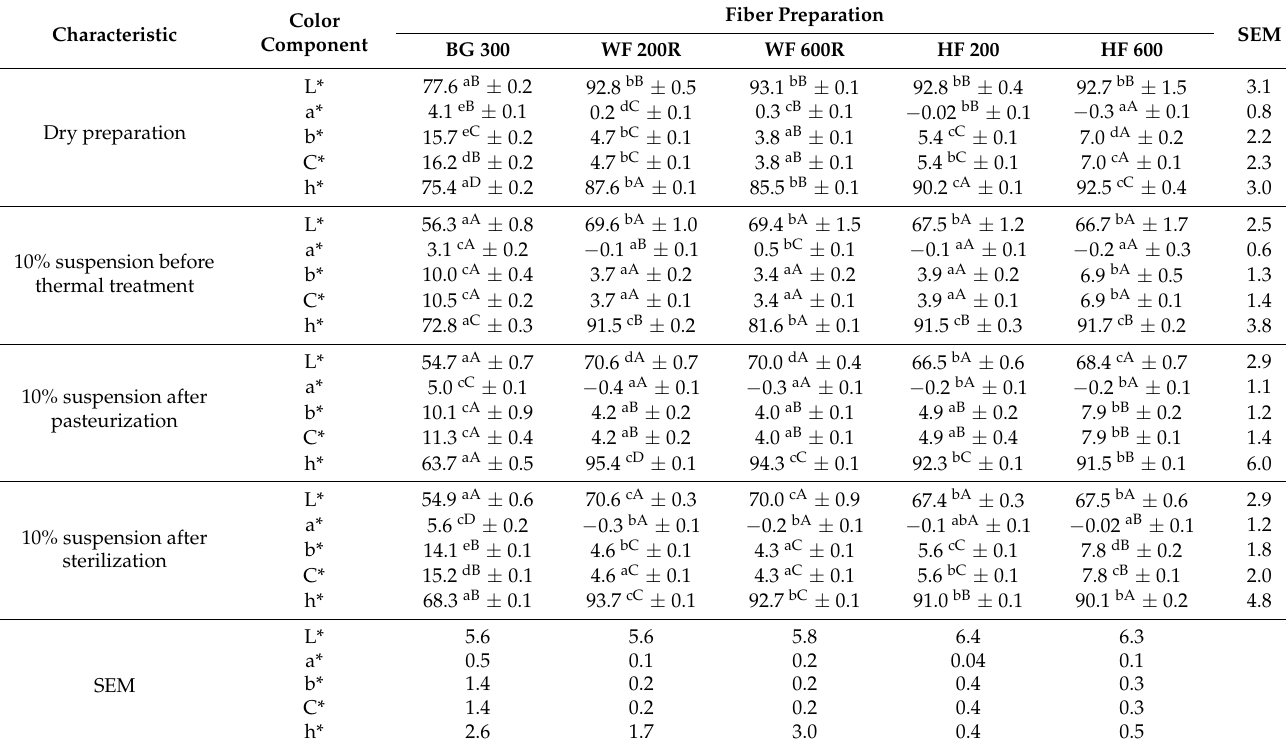
Table 1. L*, a* and b*, C* (Chroma) and h* (hue angle) color components of fiber preparations (mean ± standard deviation).